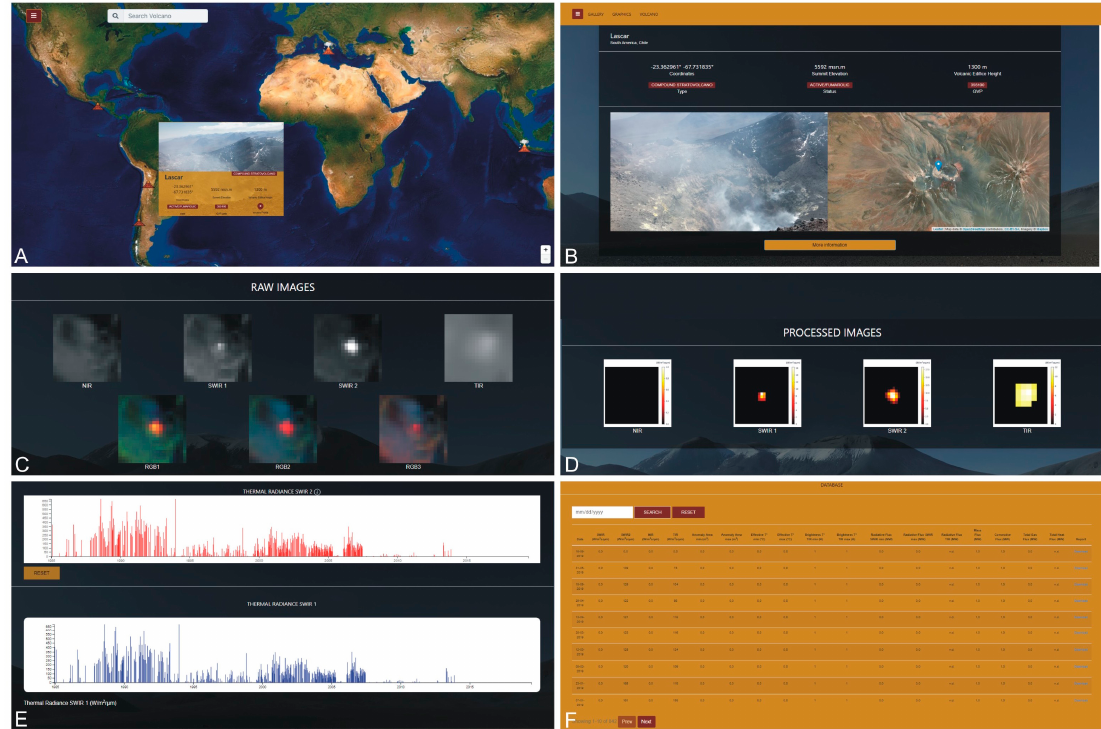
Figure 4. The Volcanic Anomalies Monitoring System (VOLCANOMS) public web page. ( A ) Home page and the volcano informative window. ( B ) Volcano general information. ( C ) Raw images section. ( D ) Processed images section. ( E ) Graphics section. ( F ) Database section.